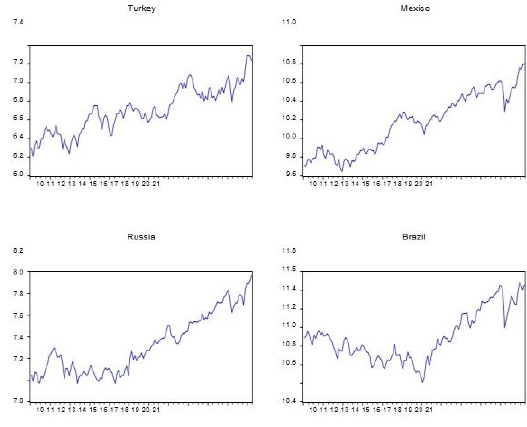
Figure 1. Stock Indices by Country